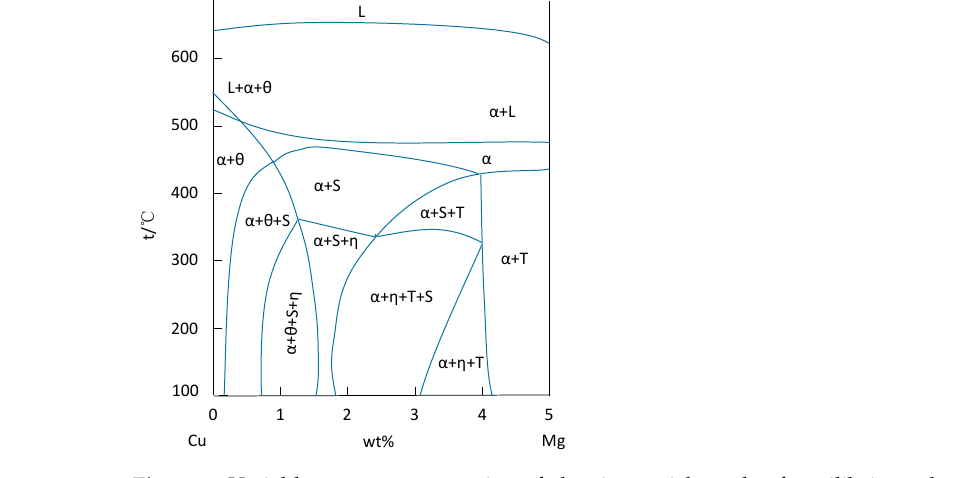
Figure 6. Variable temperature section of aluminum rich angle of equilibrium phase of 7xxx series aluminum alloy. Adapted with permission from ref. [48]. 2018 Zhang and Deng.